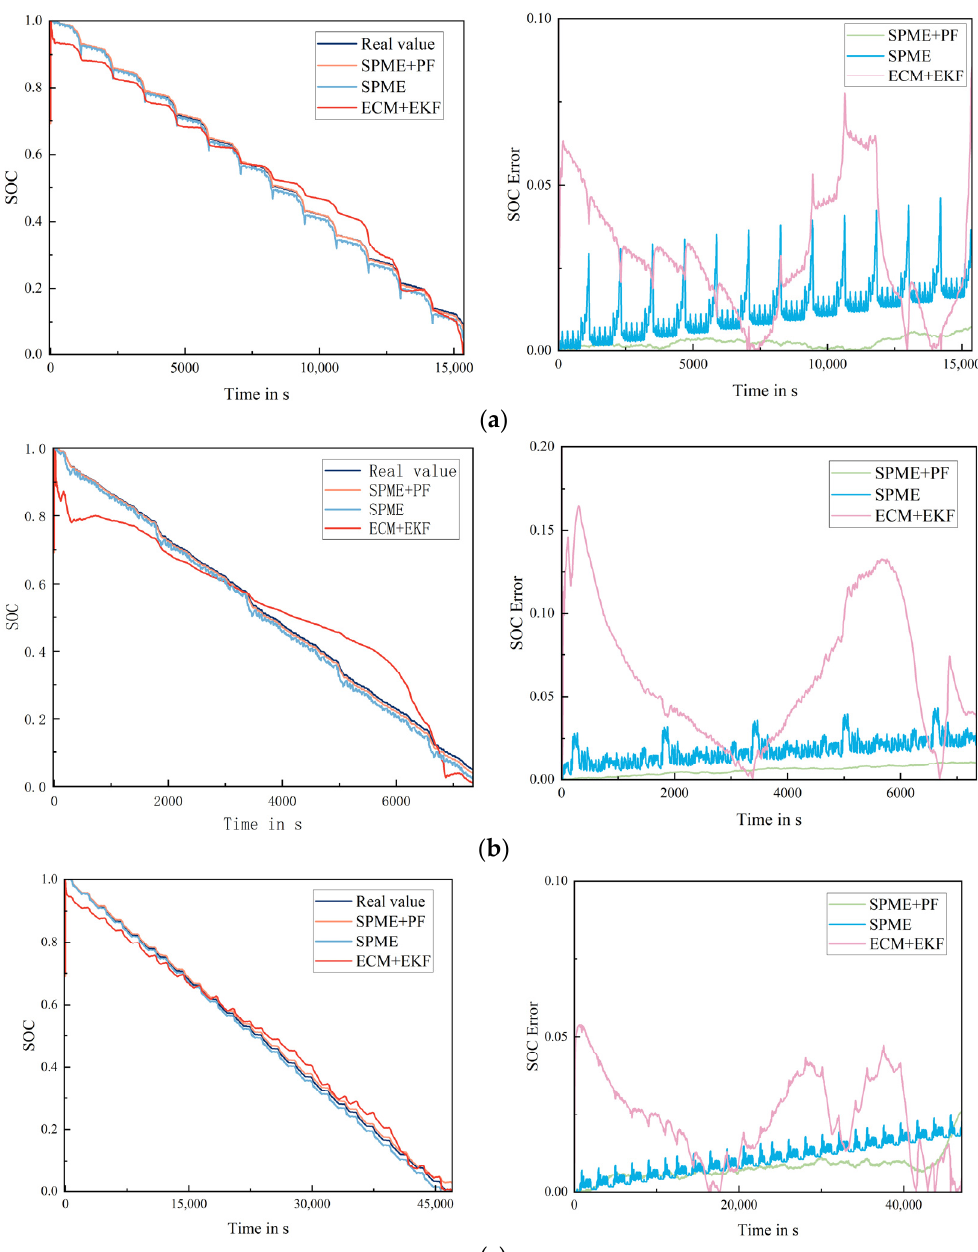
Figure 8. SOC estimation results using SPME+PF, SPME and ECM+EKF ( a ) NEDC conditions, ( b ) FTP conditions and ( c ) UDDS conditions